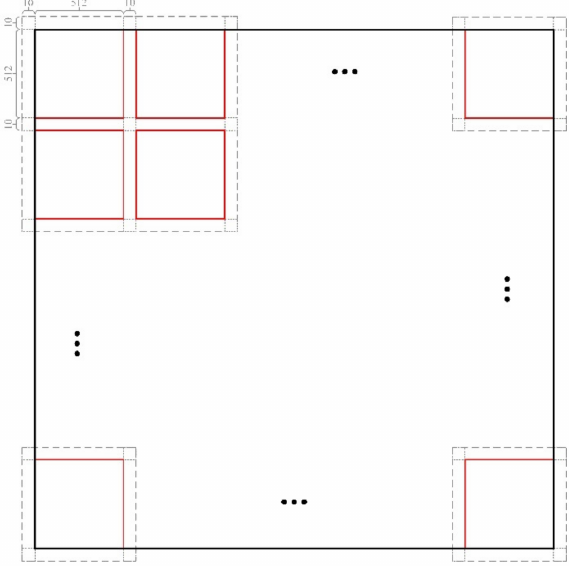
Figure 12. The principle of the “sliding window” prediction